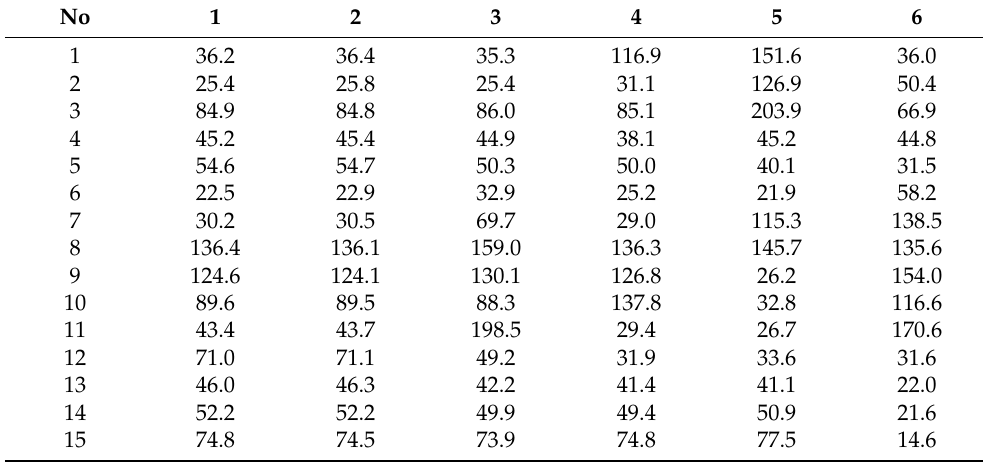
Table 2. 13 C NMR data for compounds 1 – 5 ( δ in ppm at 125 MHz for 13 C NMR in CDCl 3